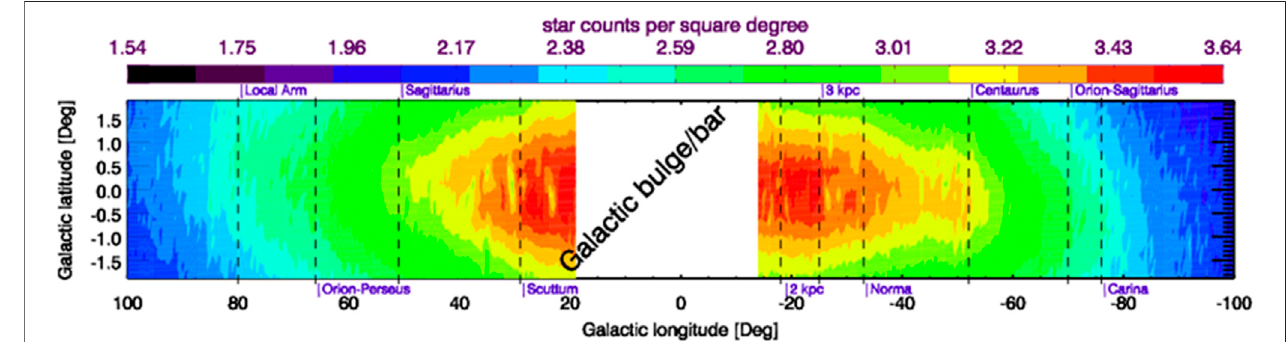
FIGURE 1 | Star counts map considering the interstellar extinction correction (counts up to K s (cid:1) 11.5 mag). The dashed vertical lines represent the longitude of tangential directions. The name of each one is presented at the top and bottom of the fi gure.